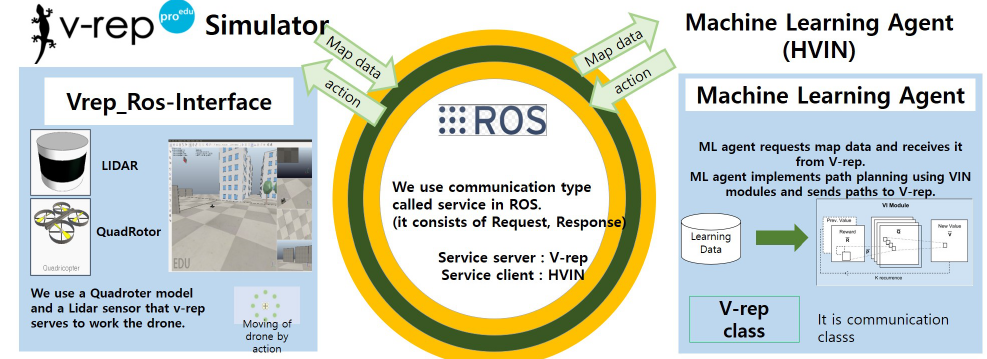
Figure 9. The proposed training and evaluation